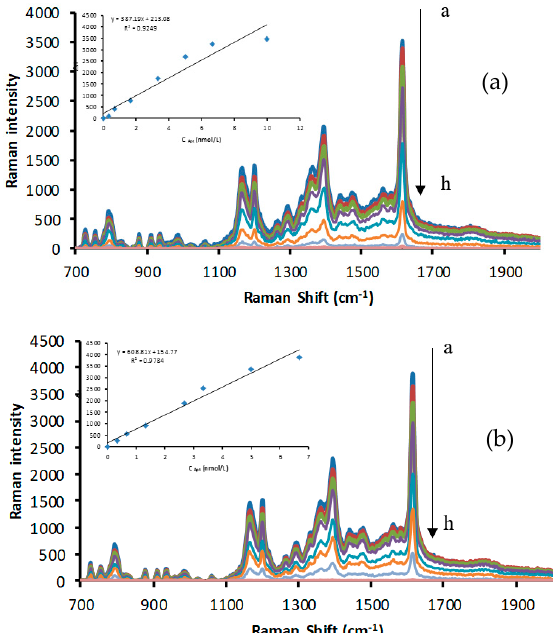
Figure 3. SERS spectra of aptamer (Apt) − CD − AgNO 3 − TSC: ( a ) a to h: solutions of Apt (0, 0.33, 0.67,